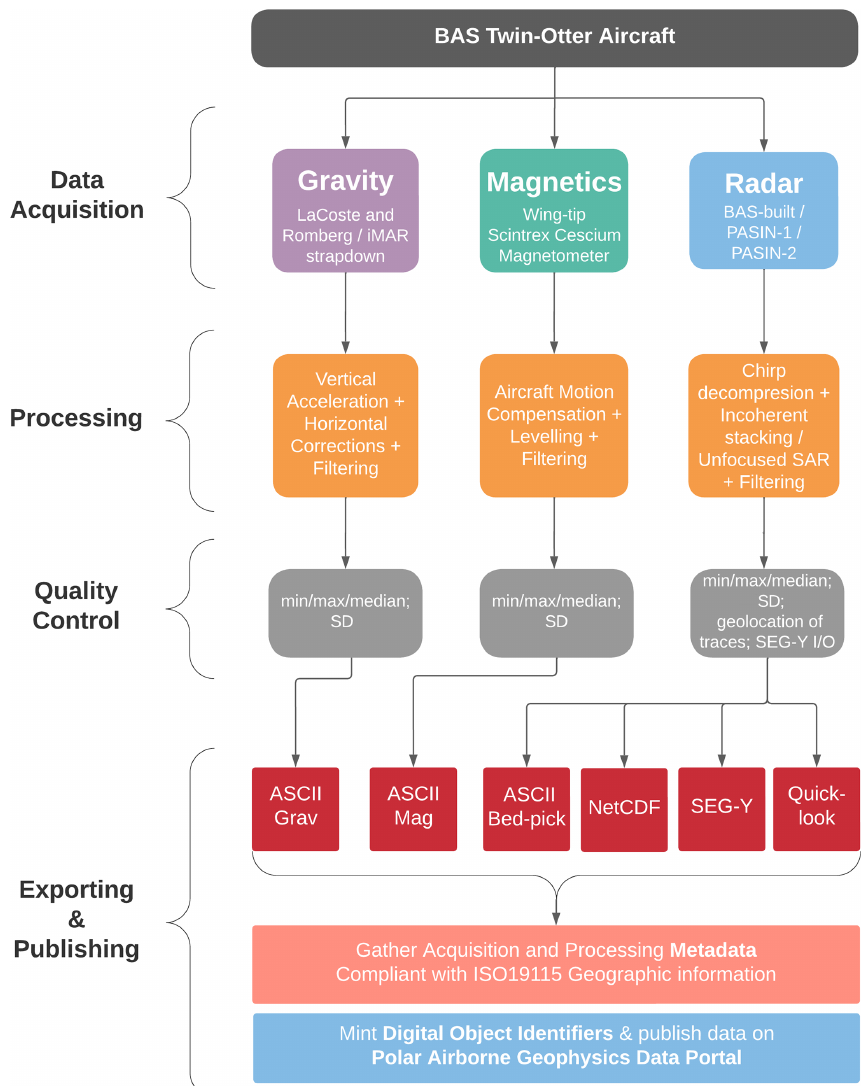
Figure 4. Workflow describing the data acquisition, processing, and publishing for the BAS aerogeophysical data included in this data release. Standard deviation is abbreviated as “SD”, whilst “I/O” refers to the import of the SEG-Y files into seismic-interpretation software for quality check and the output of the